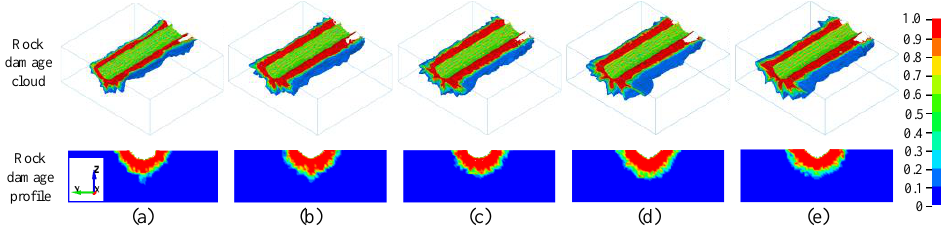
Figure 17. The rock damage clouds with different cutting speeds. ( a ) 1 m/s, ( b ) 3 m/s, ( c ) 5 m/s, ( d ) 7 m/s, ( e ) 9 m/s.